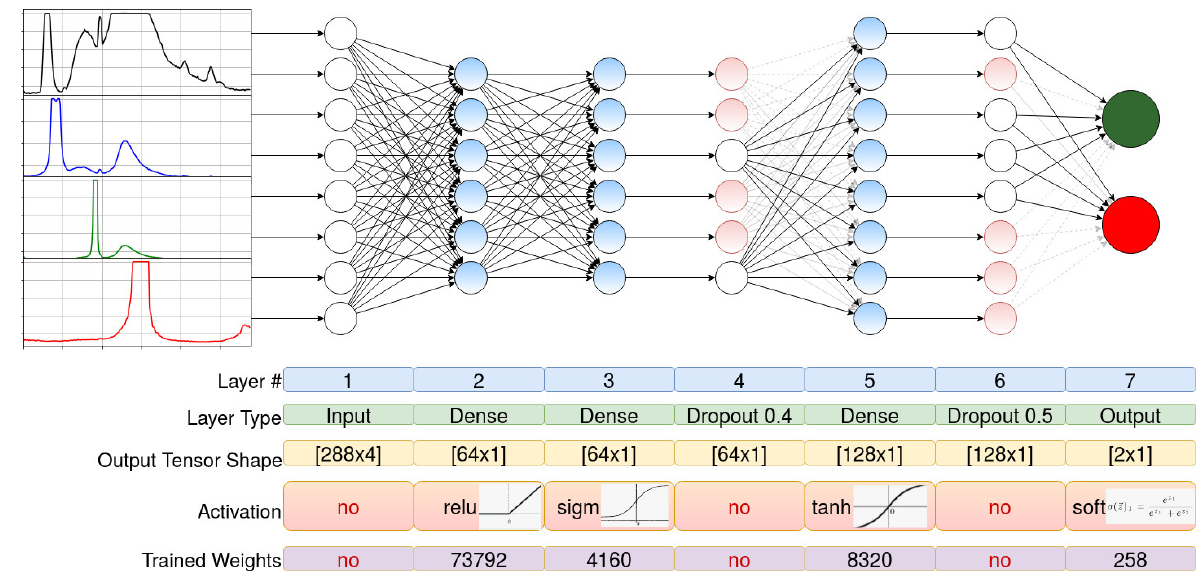
Figure 2. The architecture, loss function, and fitting parameters of the DSL-1 DNN.